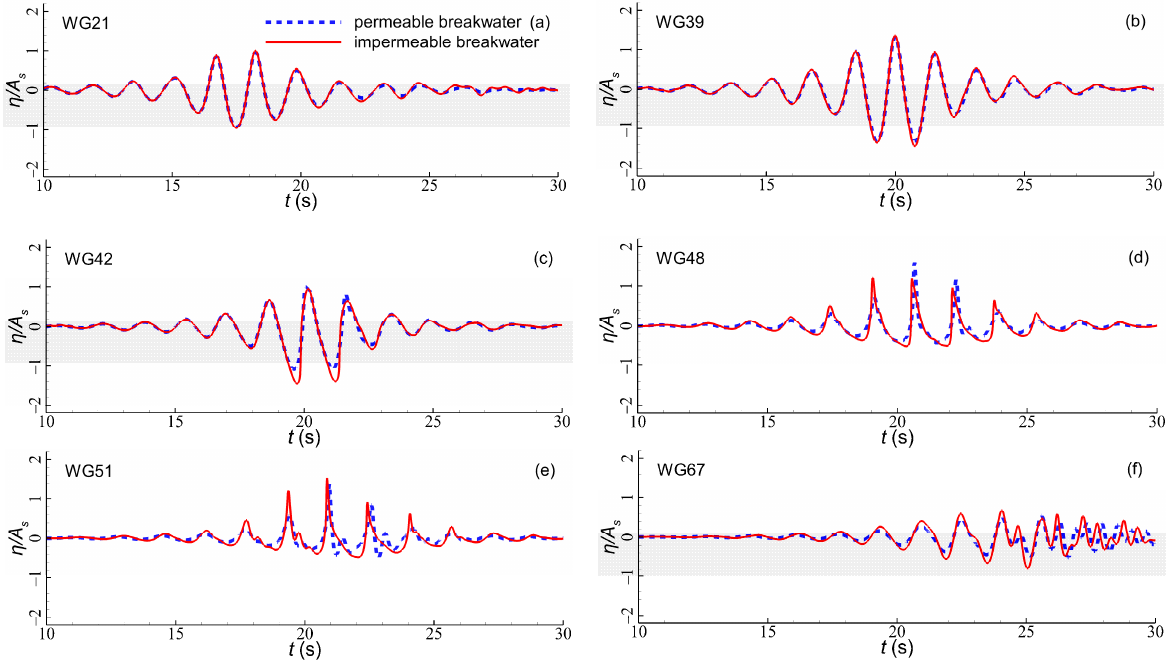
Figure 7. Comparisons of the time series of the water elevations at different wave gauges; ( a ) WG21; ( b ) WG39; ( c ) WG42; ( d ) WG48; ( e ) WG51; ( f ) WG67.